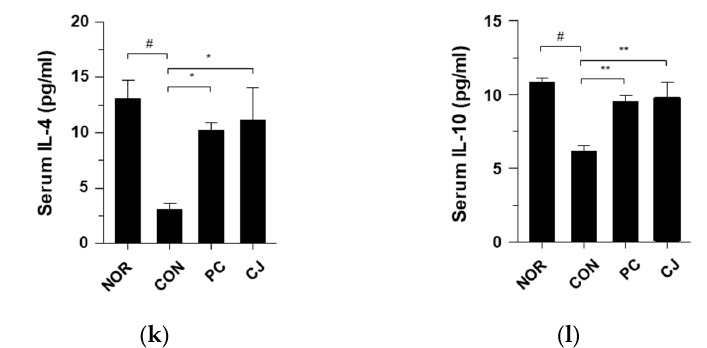
Figure 3. Effects of CJ on the expression of inflammatory cytokines in mice with AOM/DSS-induced CAC. Shown are the mRNA levels of ( a ) TNF- α , ( b ) IFN- γ , ( c ) IL-1 β, ( d ) IL-6, ( e ) IL-4, and ( f ) IL-10 in the colon and protein levels of ( g ) TNF- α , ( h ) IFN- γ , ( i ), IL-1 β, ( j ) IL-6, ( k ) IL-4, and ( l ) IL-10 in the serum. Values are mean ± standard deviation ( n = 8); NOR, normal group; CON, control group; PC, positive control group; CJ, cheonggukjang treated group. #, p < 0.05 versus normal group; ***, p < 0.001; **, p < 0.005; *, p < 0.05 versus control group.